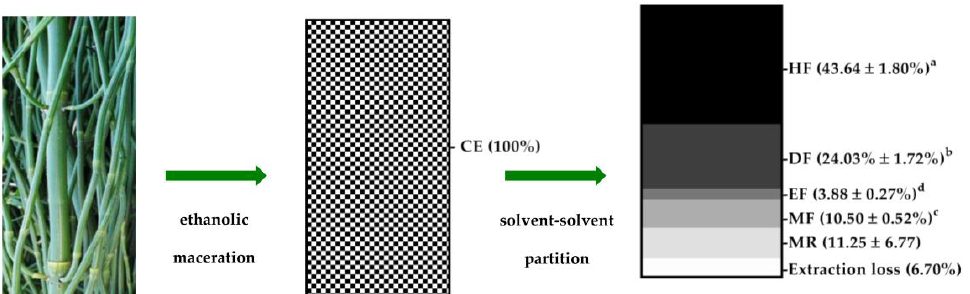
Figure 3. E. debile crude extract (CE) sequentially partitioned into semi-purified hexane fraction (HF), dichloromethane fraction (DF), ethyl acetate fraction (EF), methanol fraction (MF), and methanol insoluble residue (MR). The % yield is a ratio of fraction weight and crude extract weight. All data are presented as mean ± SD of three independent experiments. Superscript letters (a, b, c, and d) indicate significant differences of means between the groups based on Tukey’s HSD one-way ANOVA ( p -value <